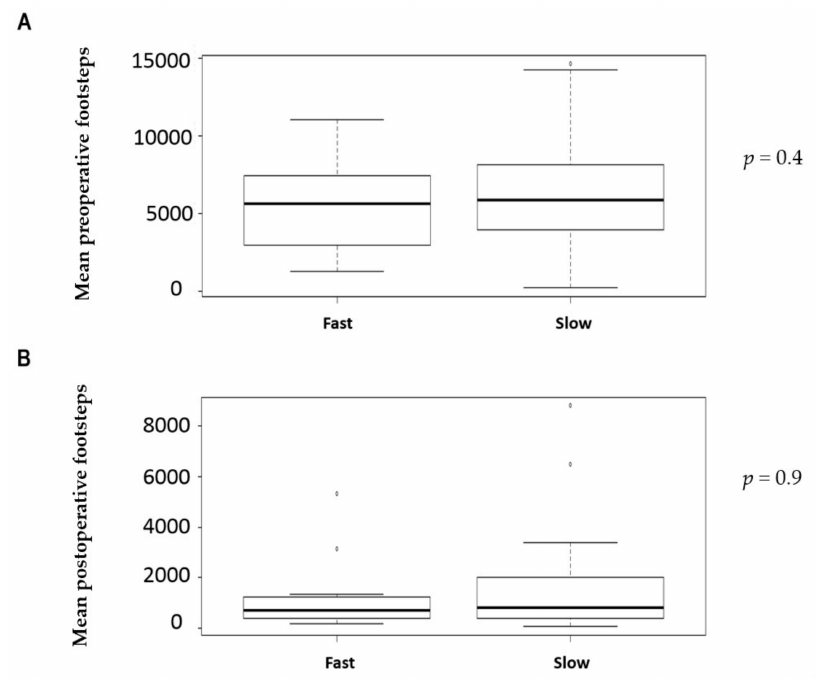
Figure 1. Comparison between 6-Minutes Walking Test (6MWT), preoperative, and postoperative footsteps: ( A ) Comparison between mean preoperative footsteps and 6MWT classification (slow vs fast); ( B ) comparison between mean postoperative footsteps and 6MWT classification (slow vs fast).